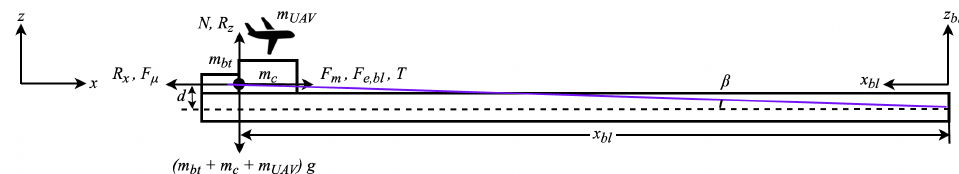
Figure 8. A free-body diagram of the BLLS-enhanced ElektRail.